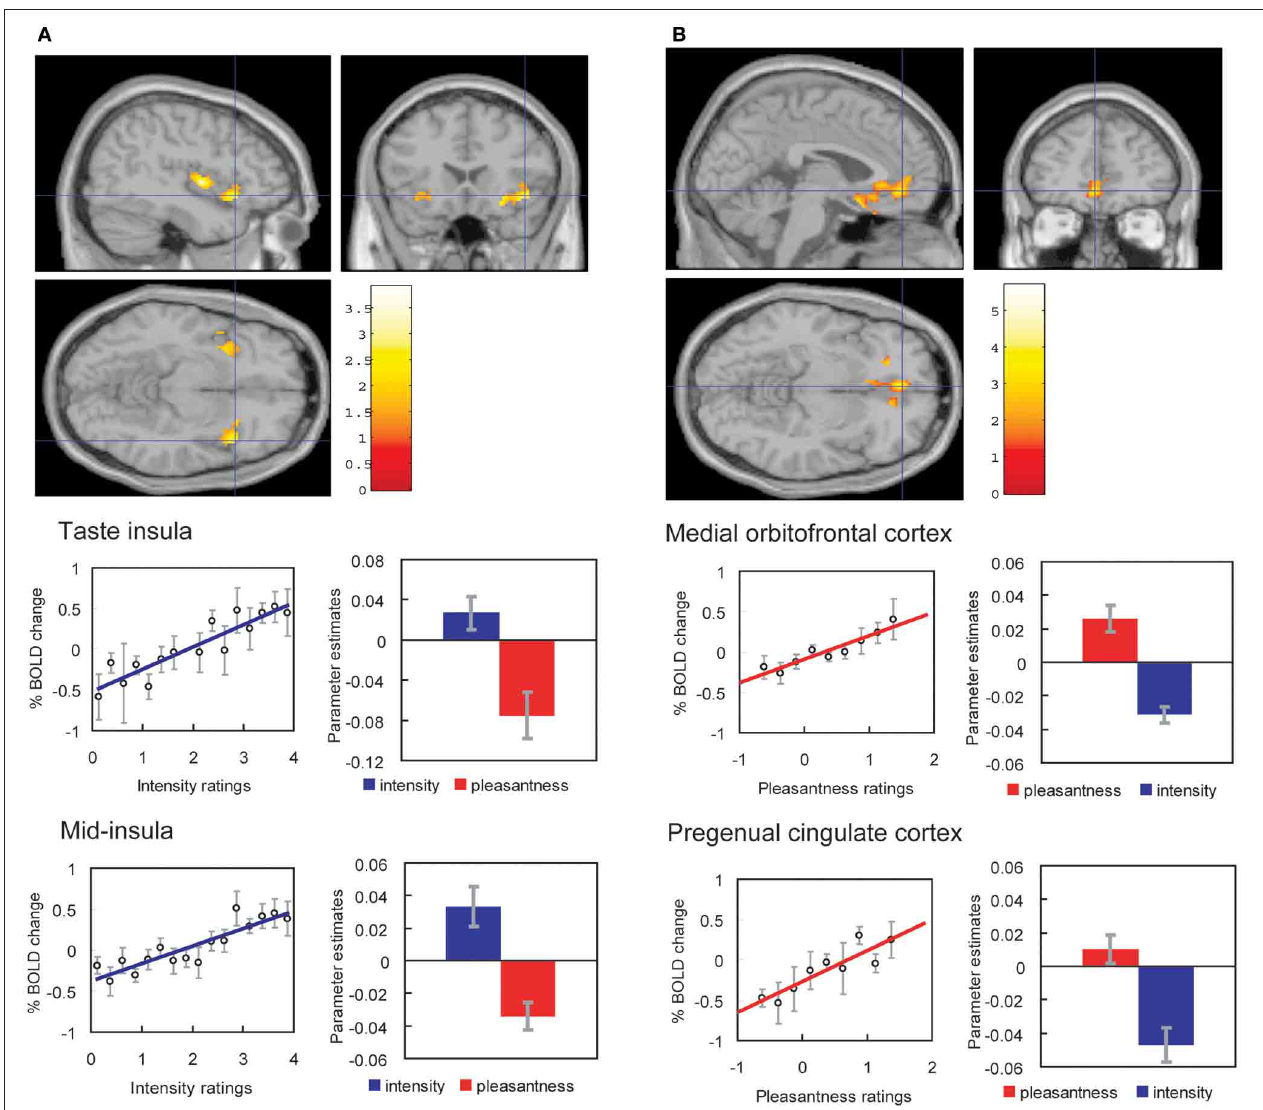
FIGURE 4 | Effect of paying attention to the pleasantness vs. the intensity of a taste stimulus. (A) Top: A significant difference related to the taste period was found in the taste insula at [42 18 − 14], z = 2 . 42, p < 0 . 05 (indicated by the cursor) and in the mid insula at [40 − 2 4], z = 3 . 03, p < 0 . 025. Middle: Taste insula. Right: The parameter estimates (mean ± SEM across subjects) for the activation at the specified coordinate for the conditions of paying attention to pleasantness or to intensity. The parameter estimates were significantly different for the taste insula t = 4 . 5, df = 10, p = 0 . 001. Left: The correlation between the intensity ratings and the activation (% BOLD change) at the specified coordinate ( r = 0 . 91, df = 14, p << 0 . 001). Bottom: Mid insula. Right: The parameter estimates (mean ± SEM across subjects) for the activation at the specified coordinate for the conditions of paying attention to pleasantness or to intensity. The parameter estimates were significantly different for the mid insula t = 5 . 02, df = 10, p = 0 . 001. Left: The correlation between the intensity ratings and the activation (% BOLD change) at the specified coordinate ( r = 0 . 89, df = 15, p << 0 . 001). The taste stimulus, monosodium glutamate, was